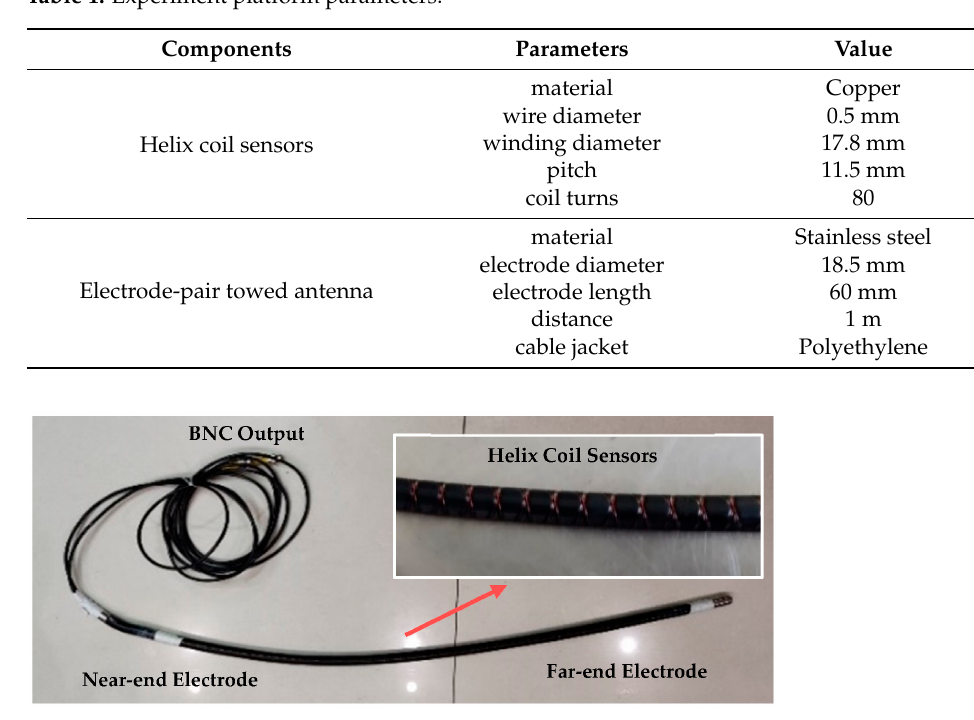
Table 1. Experiment platform parameters.